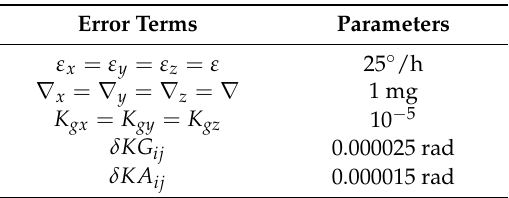
Table 1. The performance of inertial measurement element.